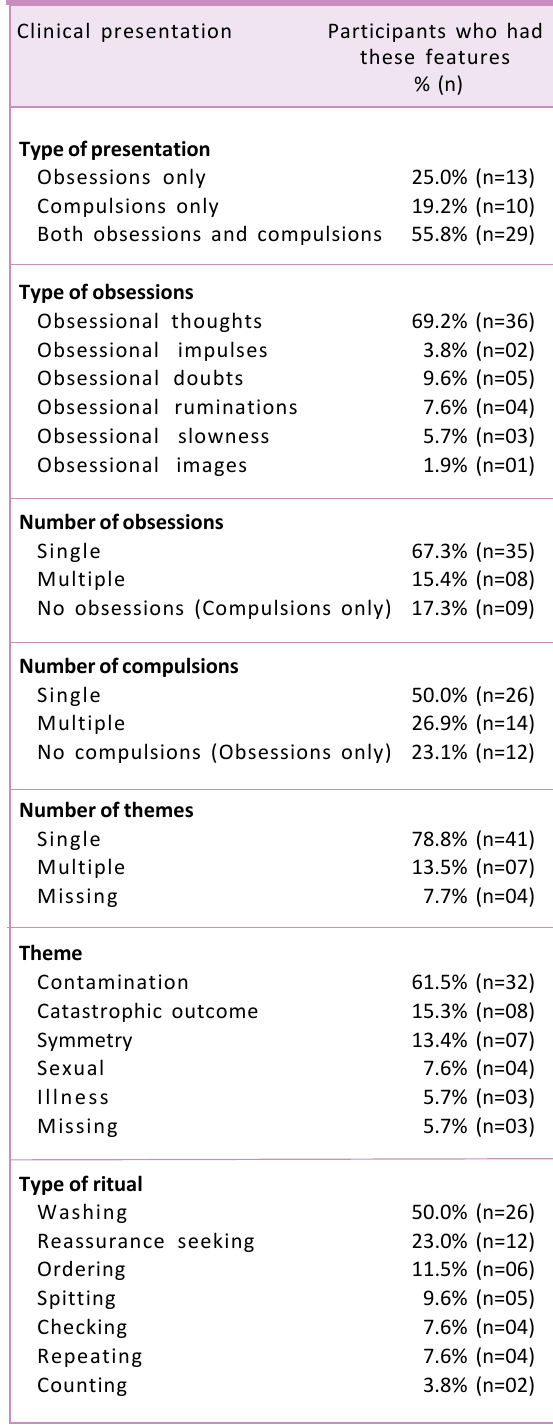
Table 1. Clinical presentation of OCD among participants in this